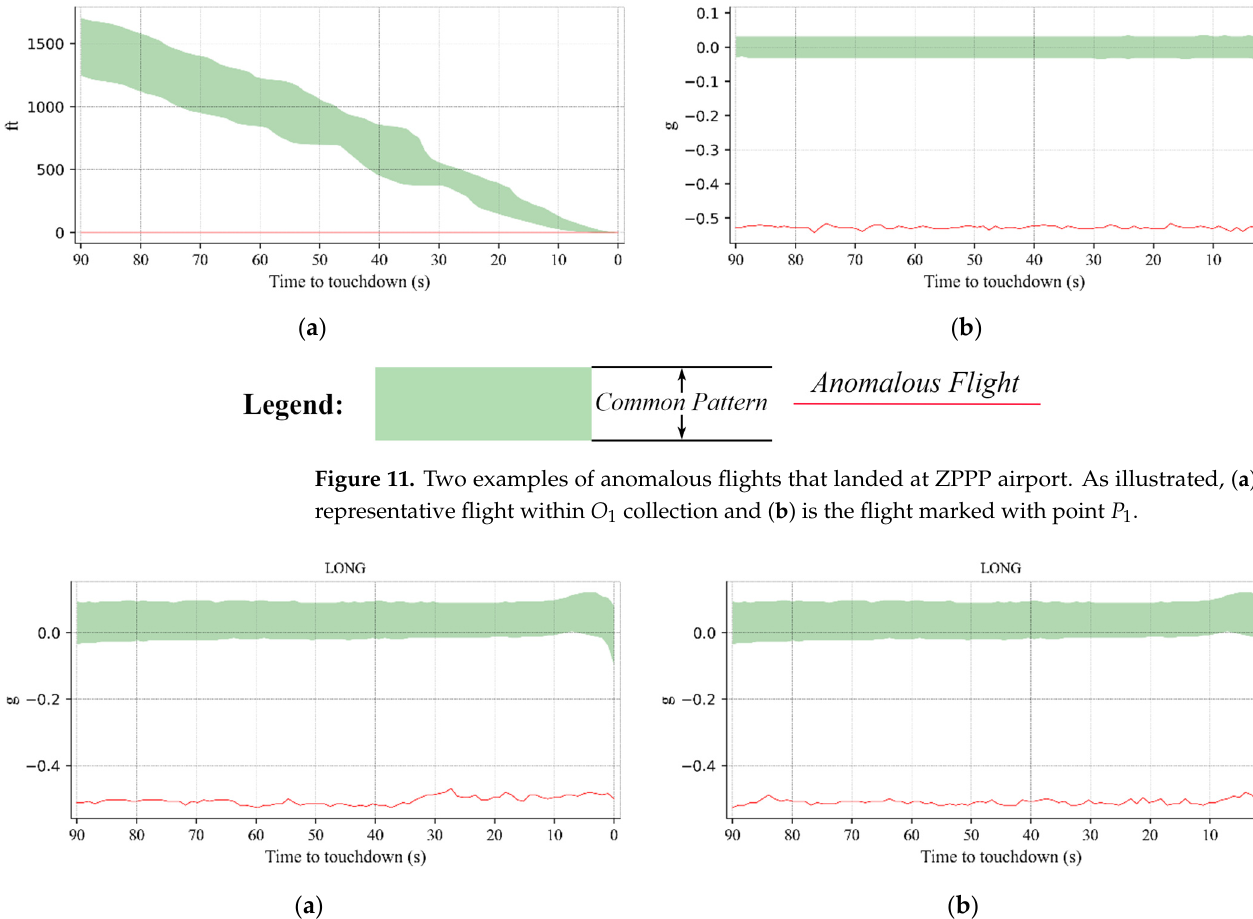
Figure 12. The two anomalous flights within the 𝑂 (cid:2870) collection. As illustrated, ( a,b ) show the lower power use of the two anomalous flights.